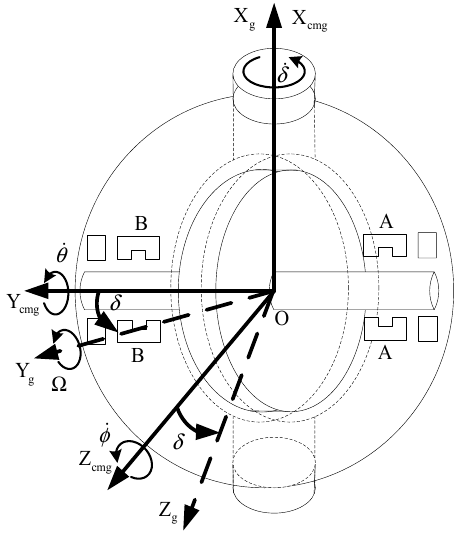
Figure 2. A sketch of the magnetically suspended SGCMG.